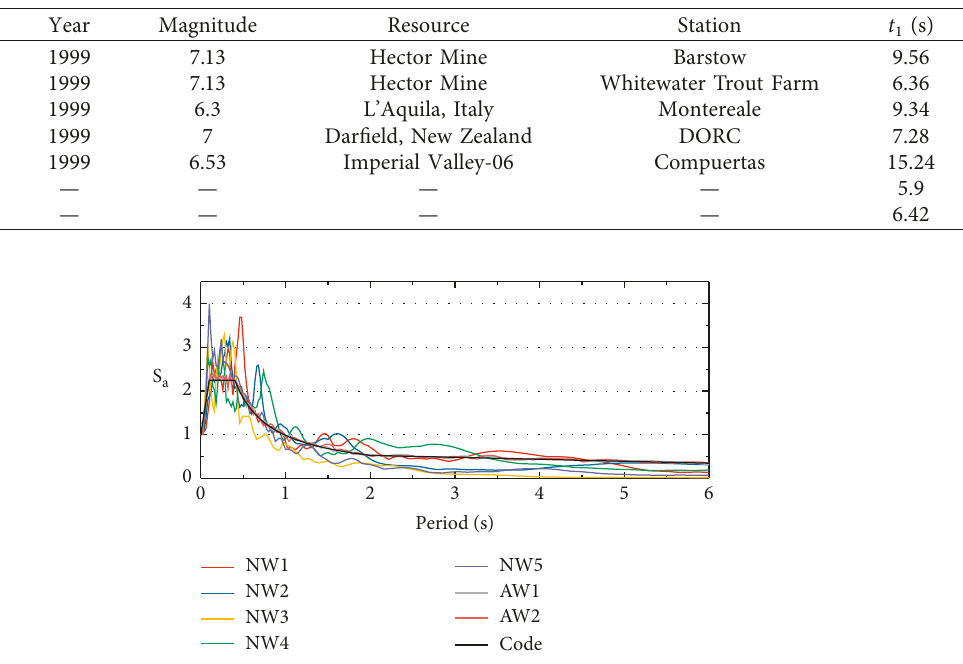
Table 6: Details of input ground motion records.